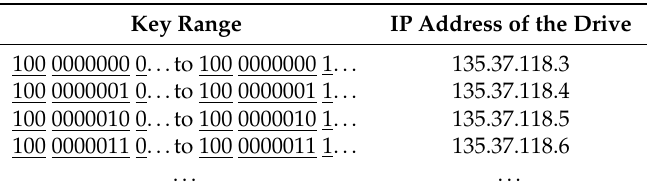
Table 1. An example of the key indexing table for original data (Region 4).